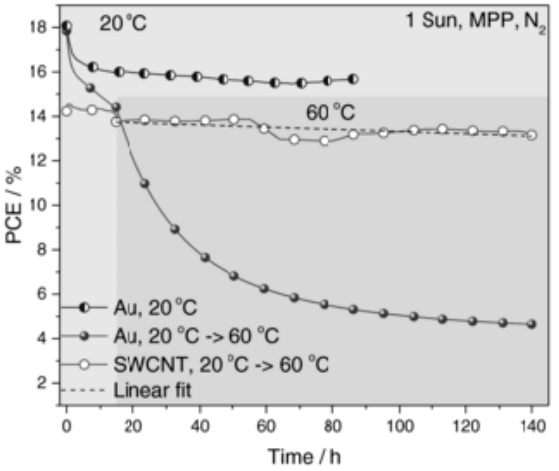
Figure 25. Maximum power point (MPP) tracking of Au and SWCNT-contacted devices at high temperatures (reproduced with permission from [156], published by John Wiley & Sons, Inc.).